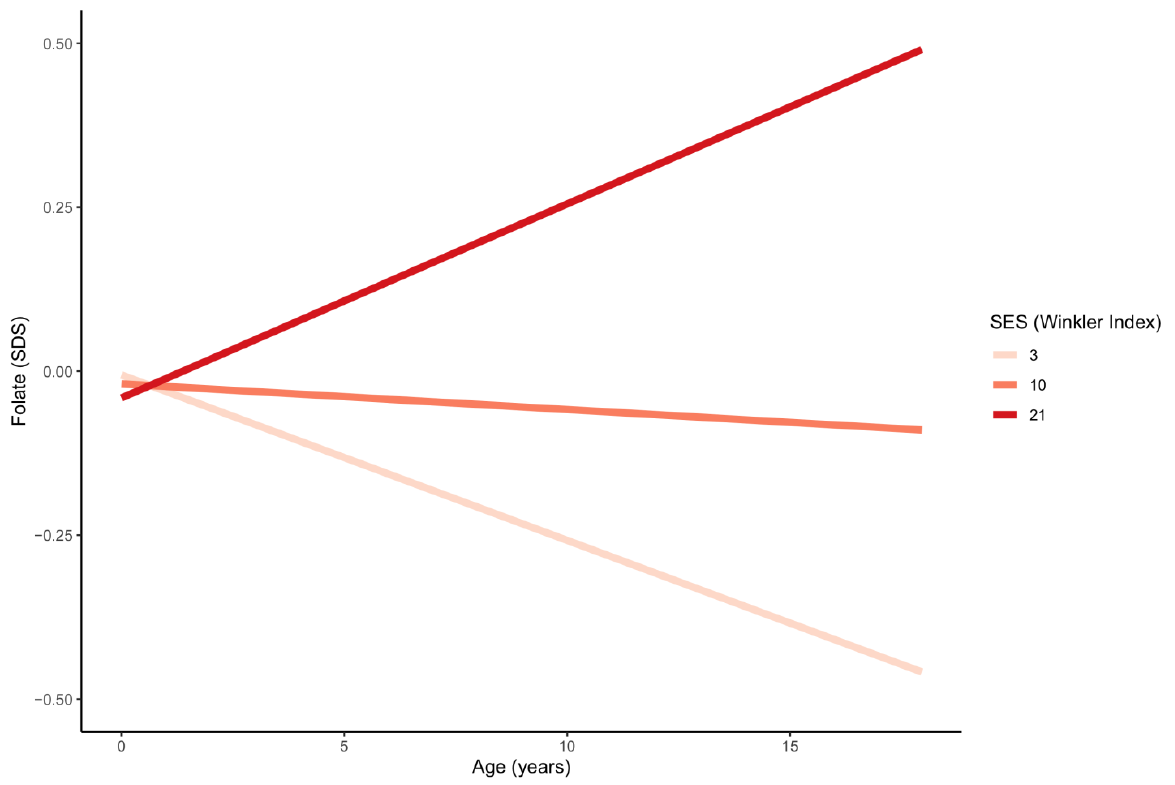
Figure 4. Age trends in serum folate for three different values of SES. SES groups: low: WI 3−8.4; middle: WI 8.5−15; high: 15.5−21. SES =socioeconomic status; WI = Winkler Index; SDS = standard deviation score.